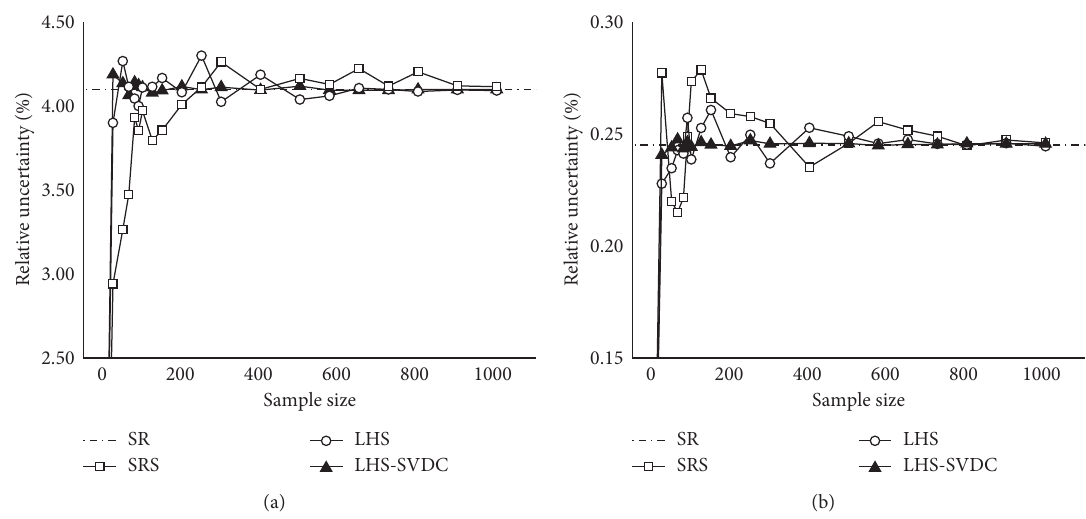
Figure 10: The contribution of 235 U ( n , c ) to the uncertainty of 235 U resonance absorption XS by using different sampling methods with different sample sizes. (a) 18 th group. (b) 22 nd